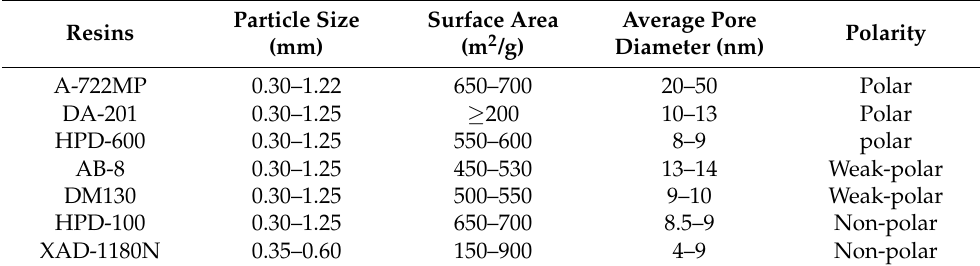
Table 1. Chemical and physical properties of the macroporous resins